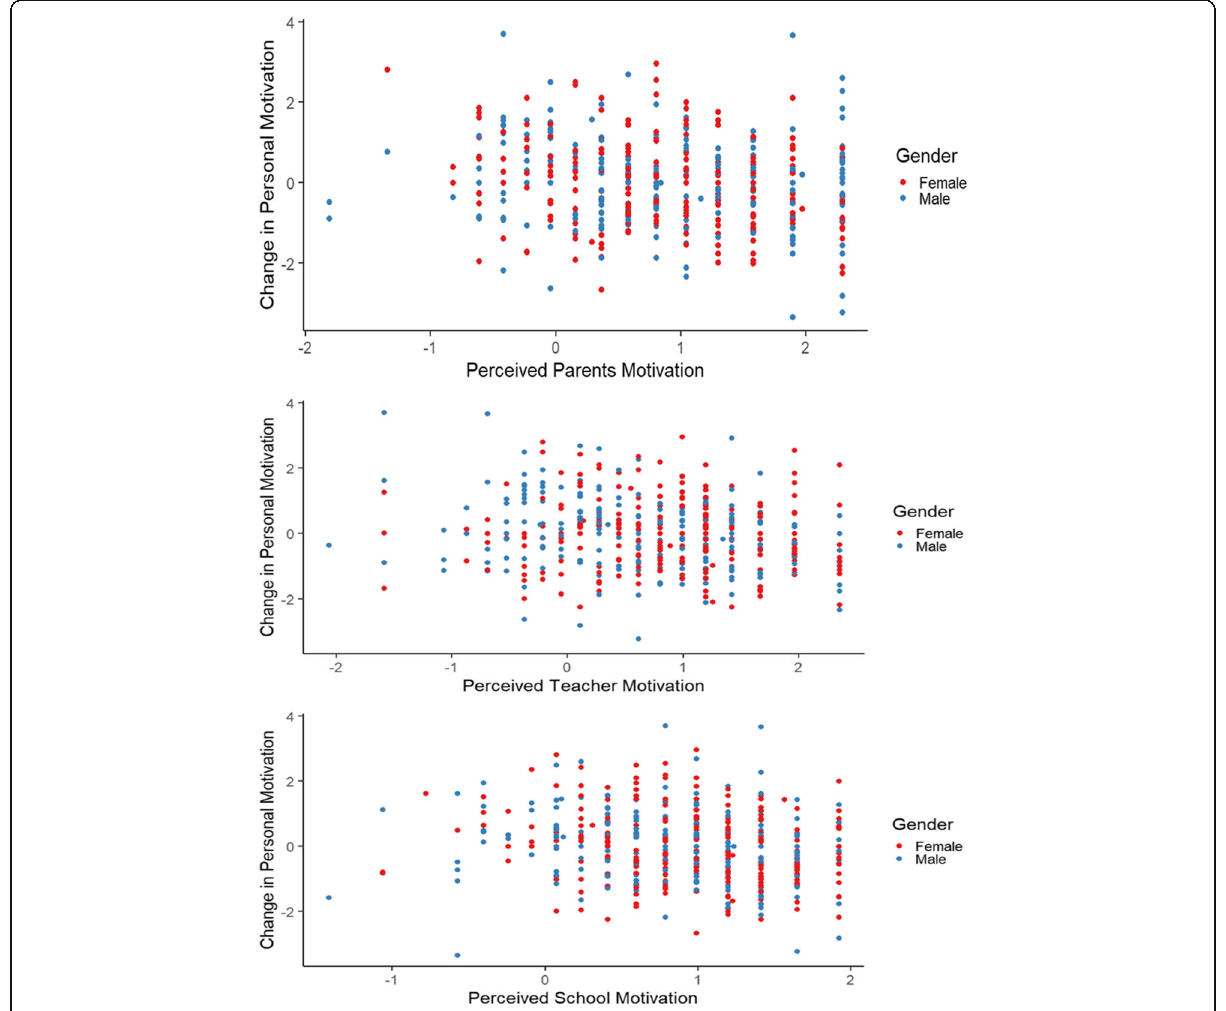
Fig. 1 Changes to personal MAOTS vs. perceived environmental emphases on